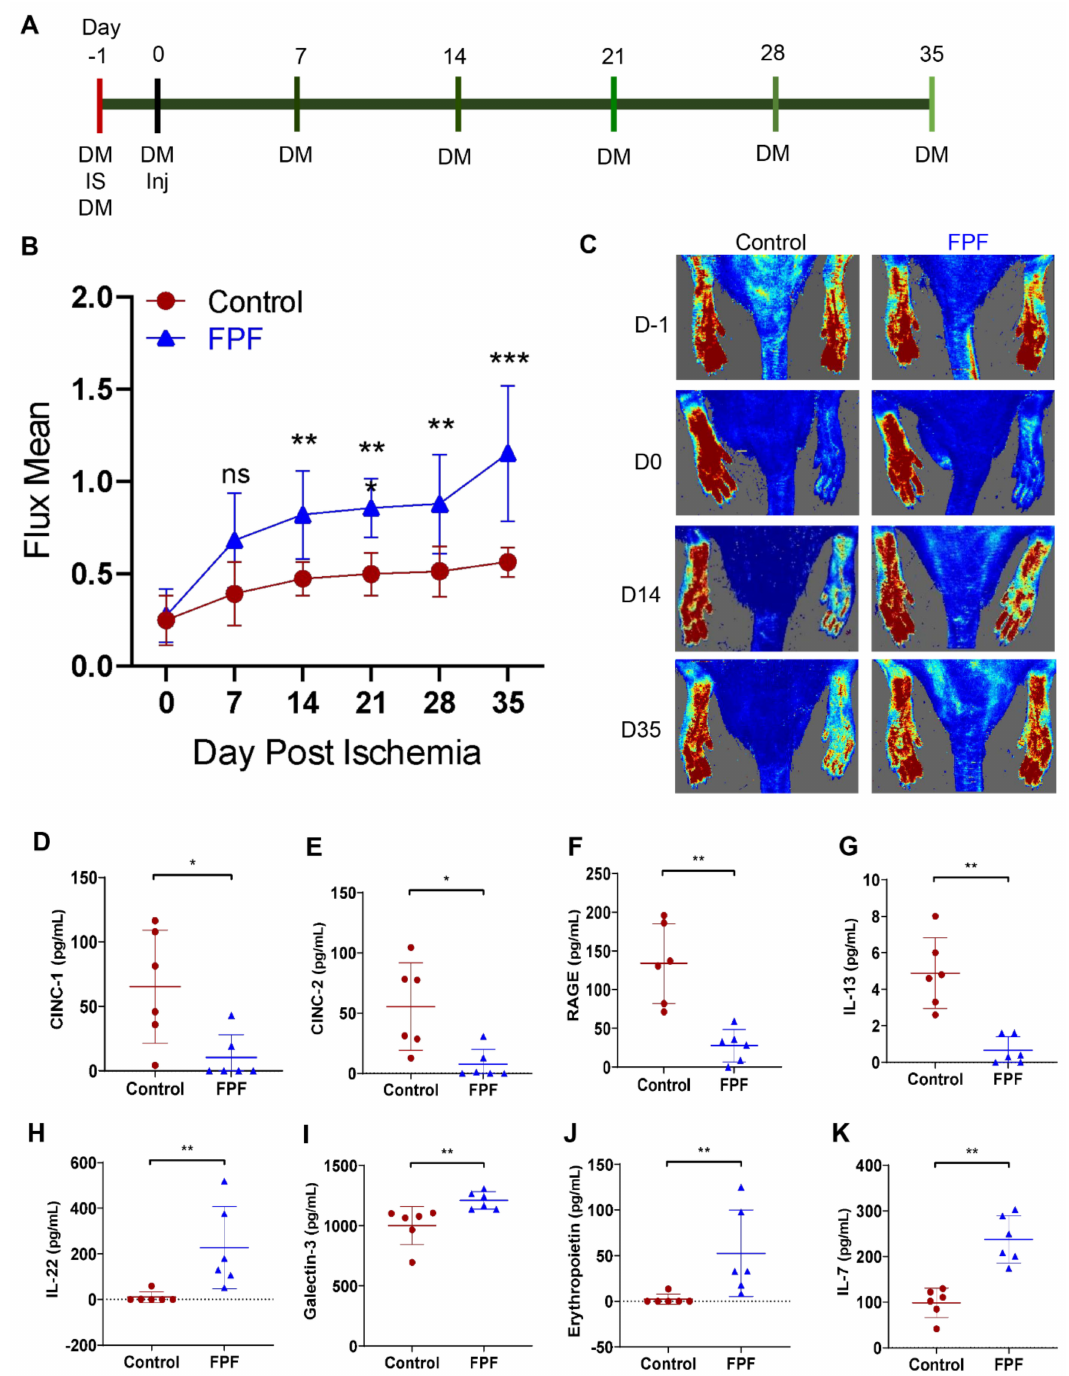
Figure 3. FPF restores tissue perfusion in a rat hindlimb ischemia model. ( A ) In vivo study timeline. DM = Doppler measurement, IS = ischemia surgery, Inj = FPF or saline injection. ( B ) Hindlimb perfusion measurements for animals treated with control or FPF. N = 10. Readings shown were taken after animals had been under anesthesia under imager for 10 min. ns: not significant. ( C ) Representative perfusion images for control (left panel) and FPF-treated (right panel) group after the animal was under anesthesia for 10 min at presurgery, the day of injection (1 day after ischemia induction), and day 35 post-treatment. Healthy limbs are on the left and ischemic/treated limbs are on the right. Levels of inflammatory and anti-inflammatory cytokines and chemokines in the Gracilis muscle at day 35 post-treatment for ( D ) CINC-1, ( E ) CINC2, ( F ) RAGE, ( G ) IL-13, ( H ) IL-22, ( I ) galectin-3, ( J ) erythropoietin, and ( K ) IL-7. N = 6 rats/group. * p < 0.05, ** p < 0.01, *** p <